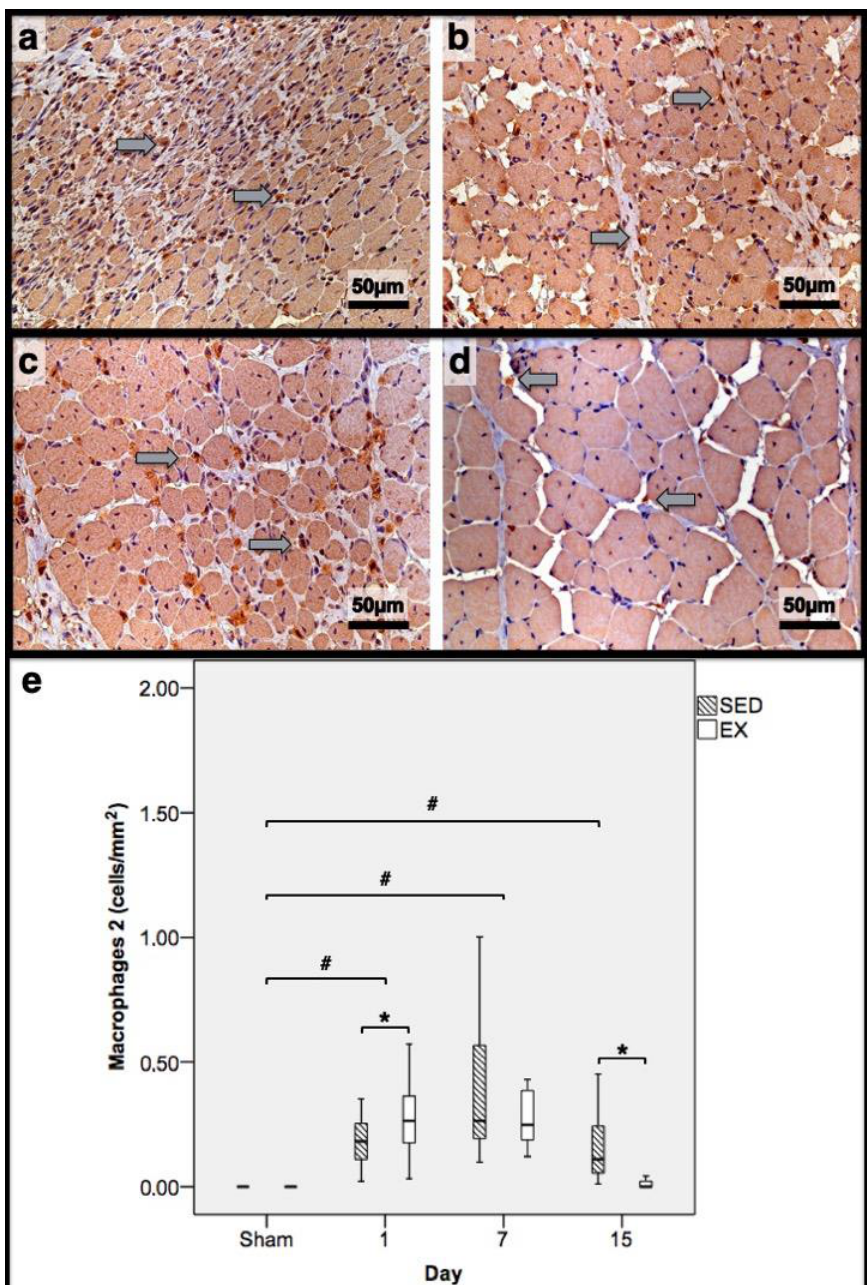
Figure 4. Immunohistochemistry of macrophages 2 (expressing mannose receptor) in the tibial anterior muscles from the exercise (EX: ( a , c )) and sedentary (SED: ( b , d )) groups injected with cardiotoxin, sacrificed on the 7th and 15th day post-injection (( a , b ) and ( c , d ), respectively), and corresponding quantitative analyses ( e ) in all assessed days in both groups (Sham: overall median values of control muscles). Sham muscles in both EX and SED, injected with saline solution, represent the overall values obtained on the 7th day post-injection. The images clearly show the brown-stained M2 macrophage (grey arrows) infiltration, which is more pronounced in the SED group ( b , d ). Box = median, 25 to 75%; T-bars = minimum and maximum values. * significantly higher than the EX group ( p < 0.01); # signifi- cantly higher than the Sham muscles ( p < 0.01). SED—sedentary group injected with cardiotoxin; EX—exercise group injected with cardiotoxin; Sham—control muscles injected with saline